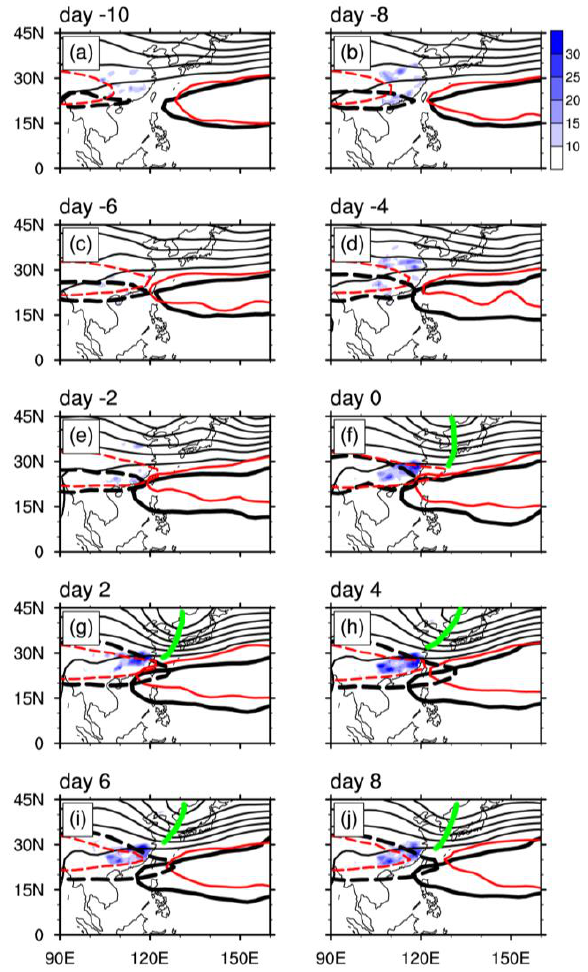
Figure 6. Composite 500 hPa geopotential heights (black contours are from 552 to 588 dagpm with interval of 4 dagpm) and daily precipitation (shading, units: mm) in EAP/SR-C events from day − 10 to day 8 with interval of 2 days ( a – j ). The thick black dashed lines (1250 dagpm-contours) and thick black solid lines (588 dagpm-contours) portray the activities of the SAH at 200 hPa and the WPSH at 500 hPa related to EAP/SR-C events (red lines are for EAP-S events). The green lines represent the mid-latitude trough.